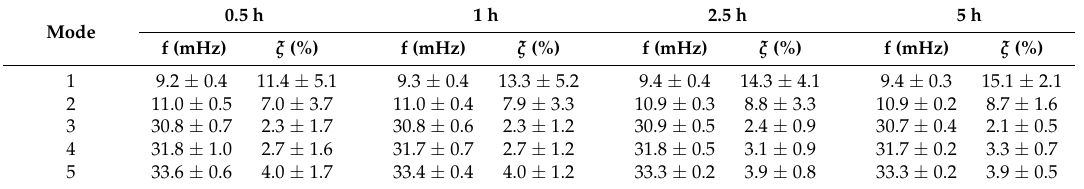
Table 8. Mean values and standard deviation obtained from the automated SSI-COV